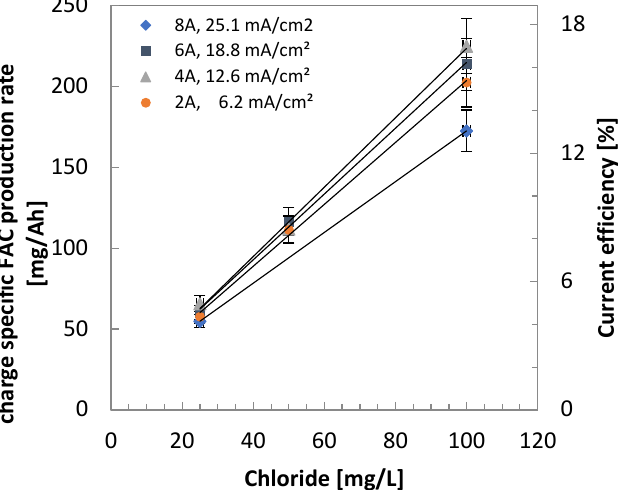
Figure 6. Relation of chloride concentration (with charge specific FAC production rate and current e ffi ciency ( n = 9) (Q = 75 L / h, EC = 400 µ S / cm, T = 19 ± 1 ◦